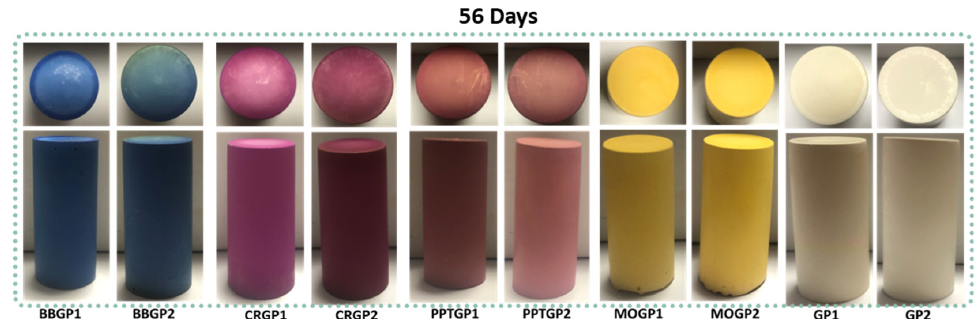
Figure 5. Images of coloured geopolymers after 56 days of ageing time. GP1 and GP2 are the respective controls for the sample cured for 24 h at 25 or 40 ◦ C.